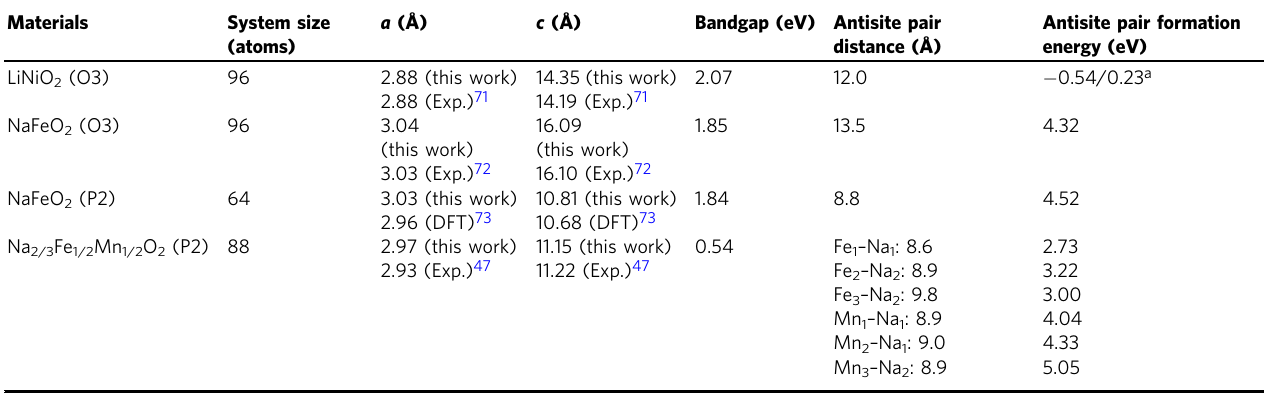
Table 1 DFT results of the lattice parameters, bandgaps, and antisite formation energies in four model systems.